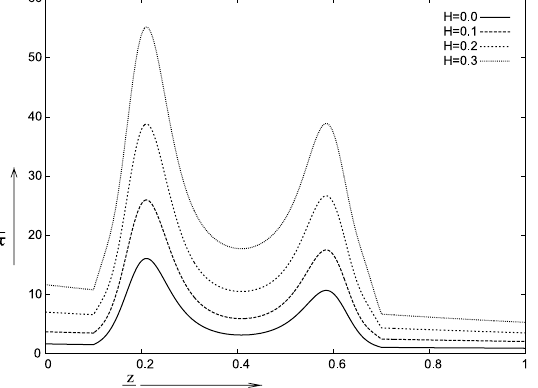
Fig. 13. Distribution of wall shear stress ¯ τ along with z for different values of H when k = 0 . 25, M = 2 . 5, β = 2 . 5, and α = 0 . 09.